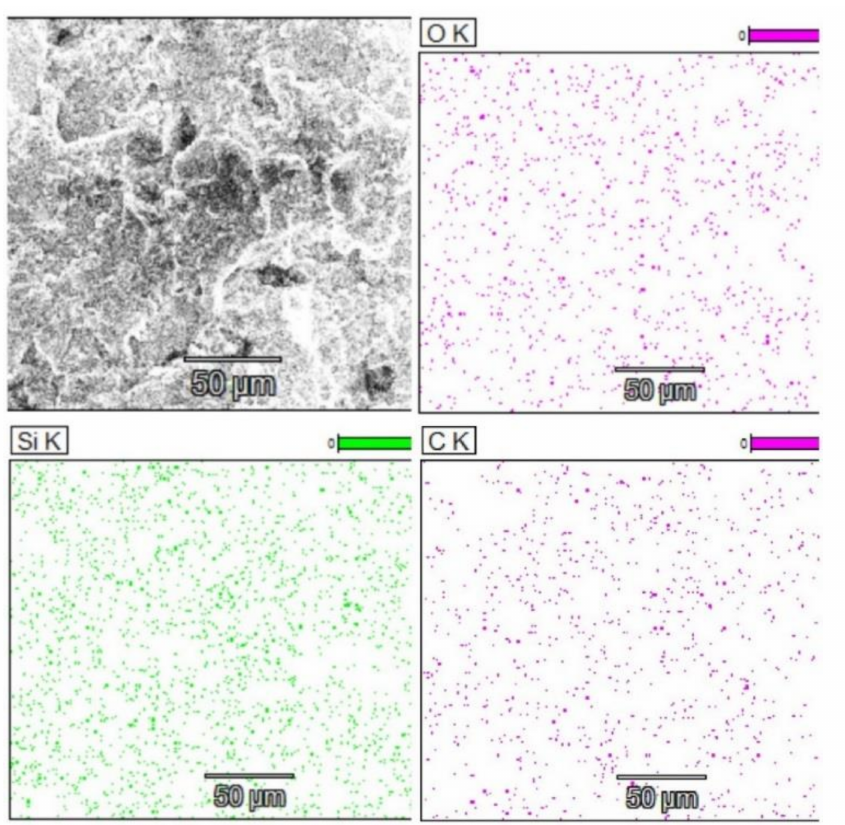
Figure 11. Density of the elements O, Si, and C on an area of 50